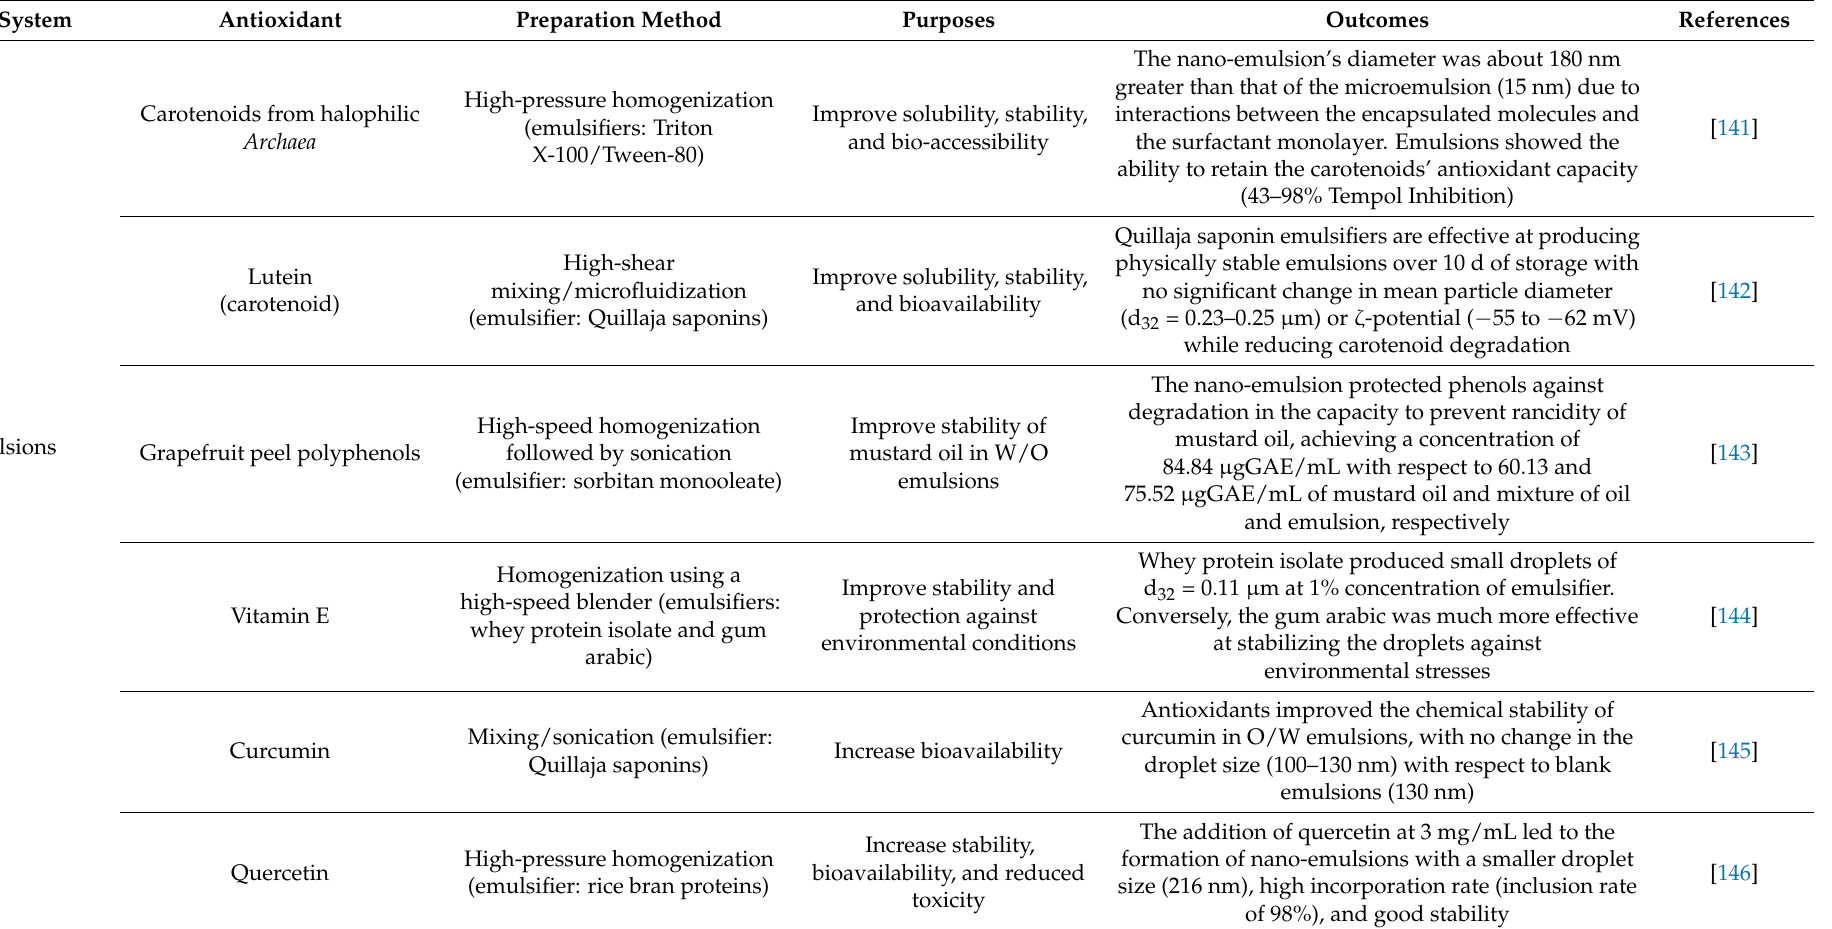
Table 2. Examples of lipid-based nanocarriers for the delivery of natural phytochemicals, with details on the preparation methods, purposes, and outcomes of